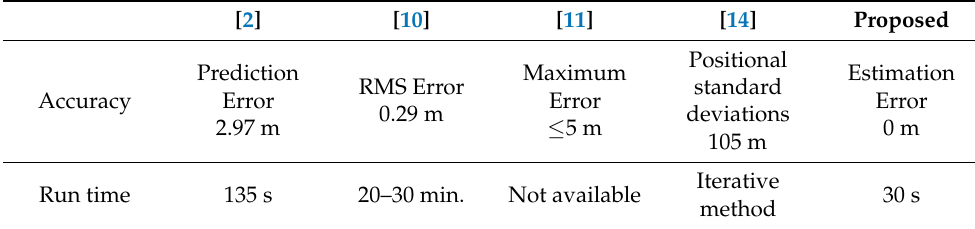
Table 1. Performance comparison of different methods. [2] [10] [11] [14]